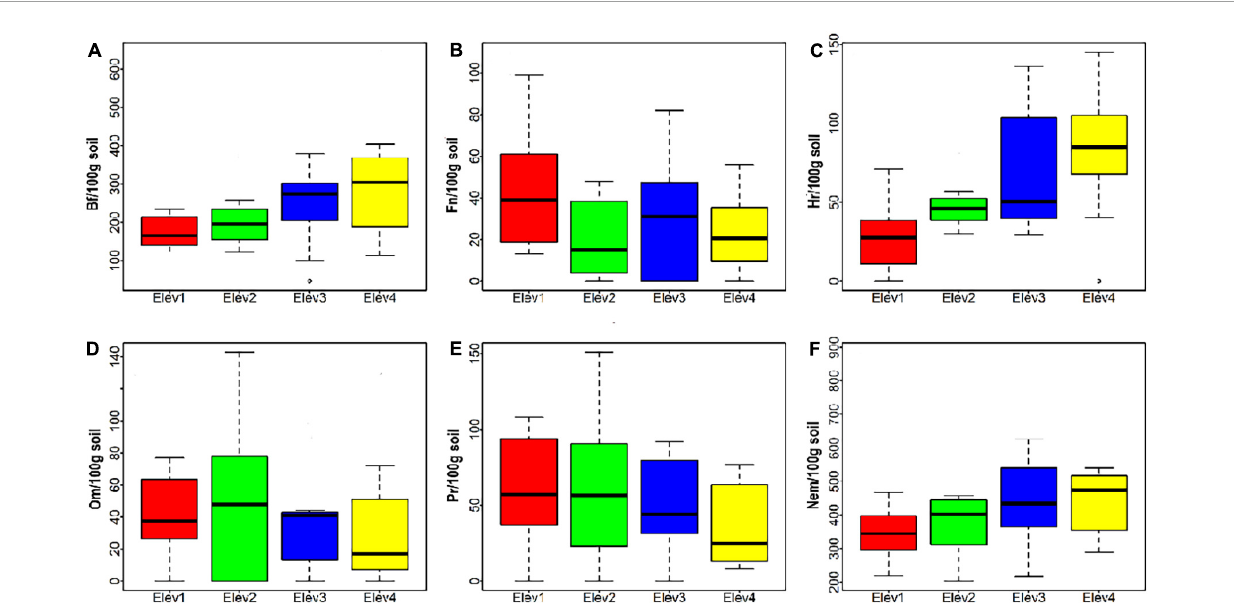
FIGURE3 Nematode abundance of various trophic groups across studied elevational classes (A) Bf, bacterivores; (B) Fn, fungivores; (C) Hr, herbivores; (D) Om, omnivores; (E) Pr, predators; and (F) nem, total nematodes. Elev, elevation; where Elev1: 1,000–1,400 m, Elev2: 1,401–1,800 m, Elev3: 1,801–2,200 m, and Elev4: 2,201–2,600 m.